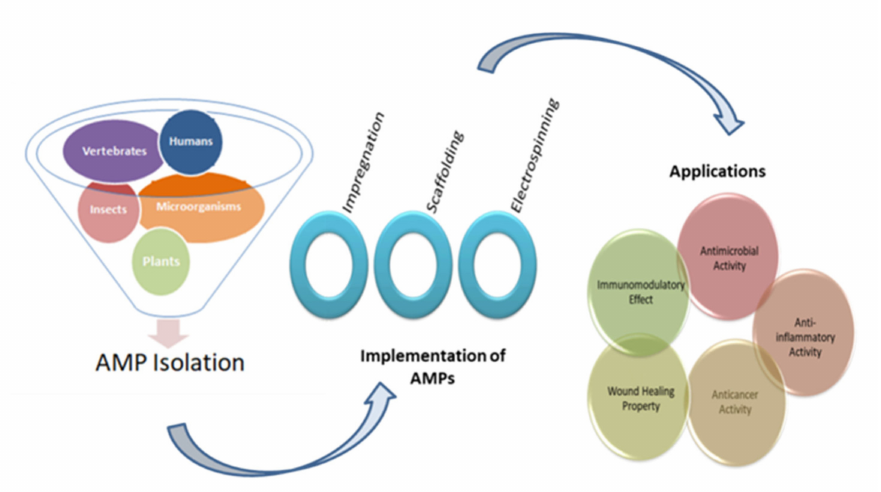
Figure 1. Diagrammatic representation of the five main sources for the isolation of AMPs, three widely used implementation techniques, and their